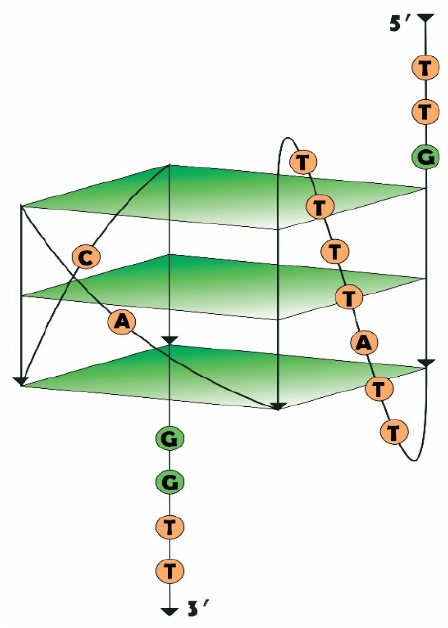
Figure 1. The proposed structure of RHA0385 as a parallel G-quadruplex with three propeller loops; one of them is 7 nucleotides long (a major loop), whereas two others are single-nucleotide (minor loops).